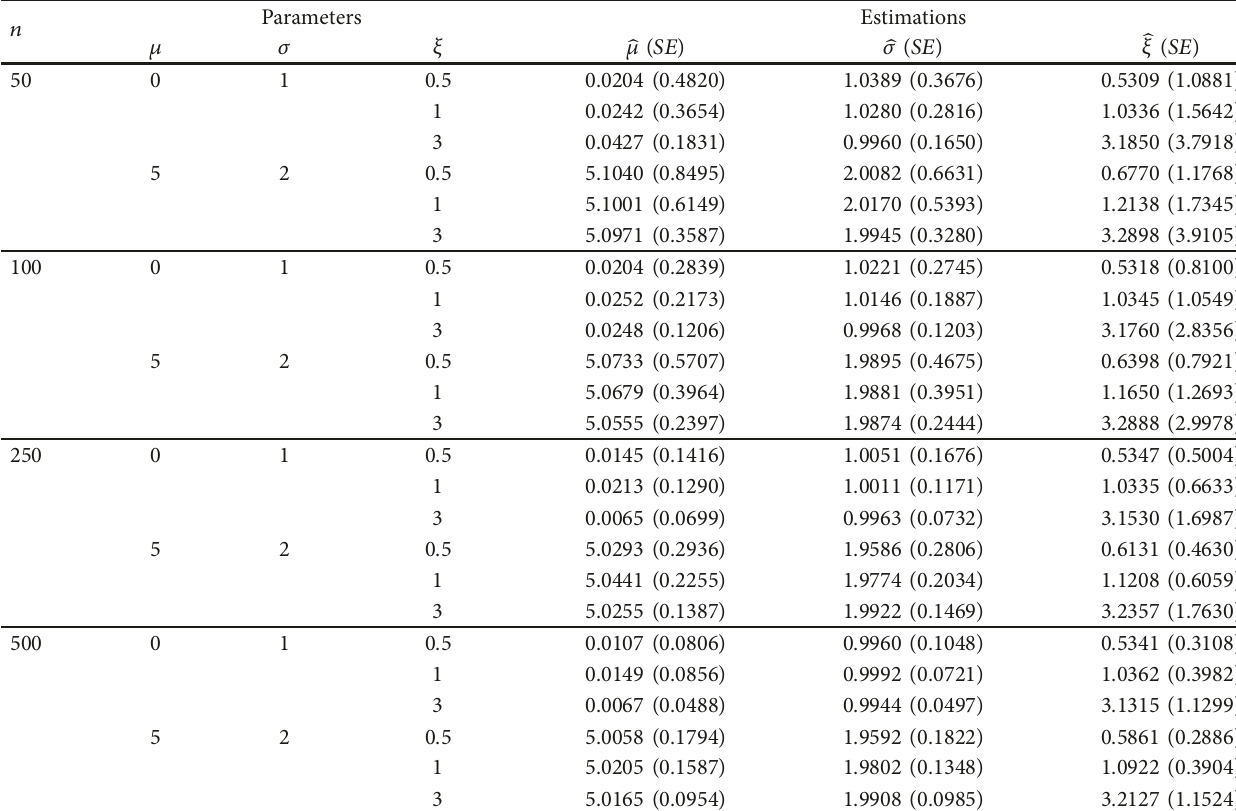
Table 2: Empirical means and standard error for maximum likelihood